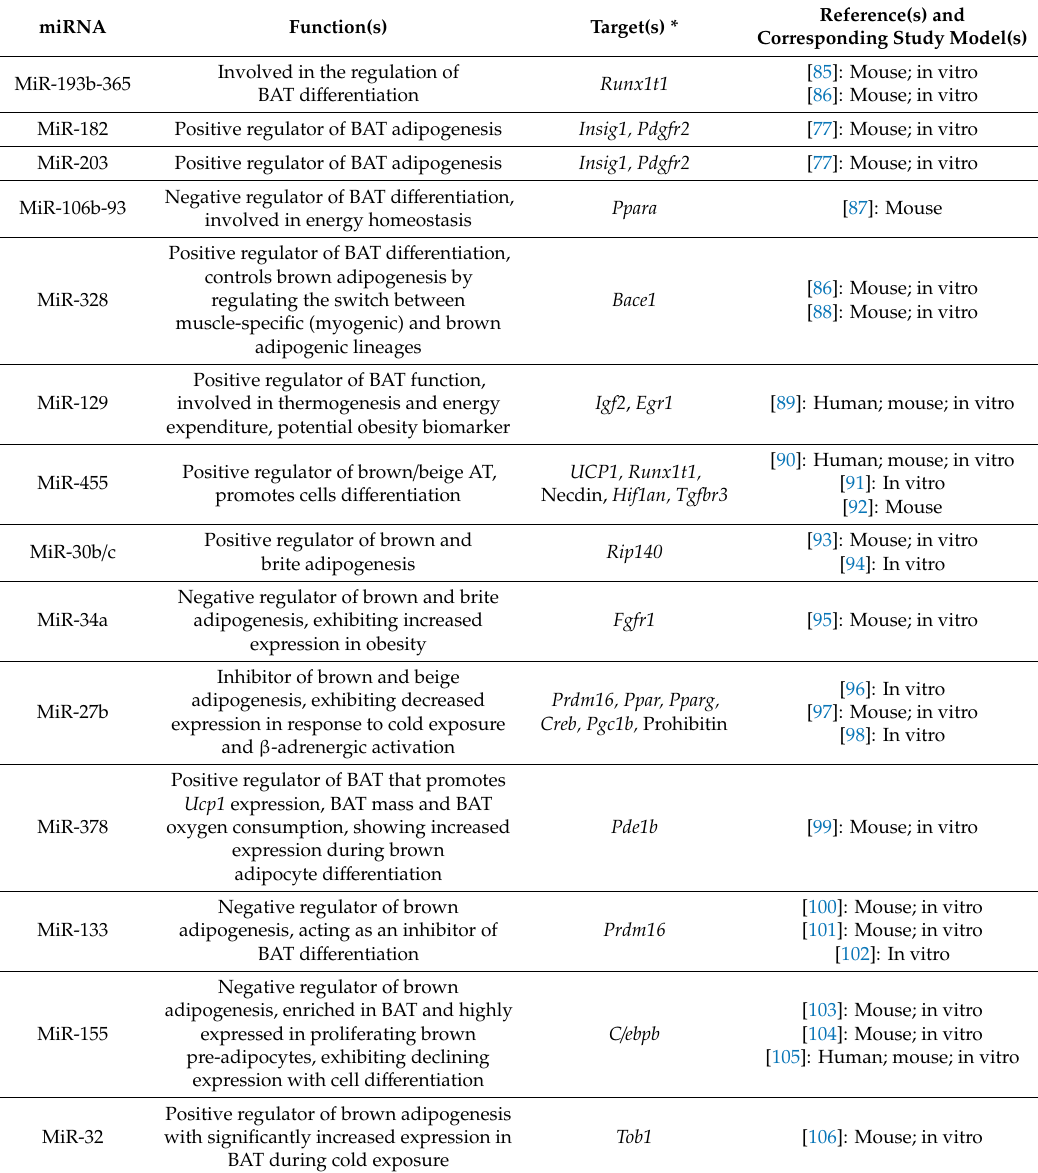
Table 1. Selected key microRNAs (miRNAs) and their reported e ff ects in brown adipose tissue (BAT).